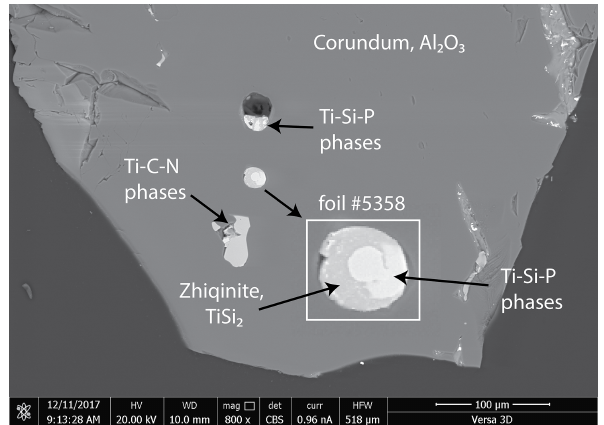
Figure 2. Back-scattered electron (BSE) image of corundum grain enclosing a spheroid composed of Ti–Si–P phases from which foil no. 5358 was taken. Inset shows enlargement of the spheroid in which a mixture of Ti 10 (Si,P, (cid:3) ) 7 and Ti 11 (Si,P ) 10 is white and zhiqinite is gray. BSE image taken at the Center for Advanced Re- search on the Mantle.